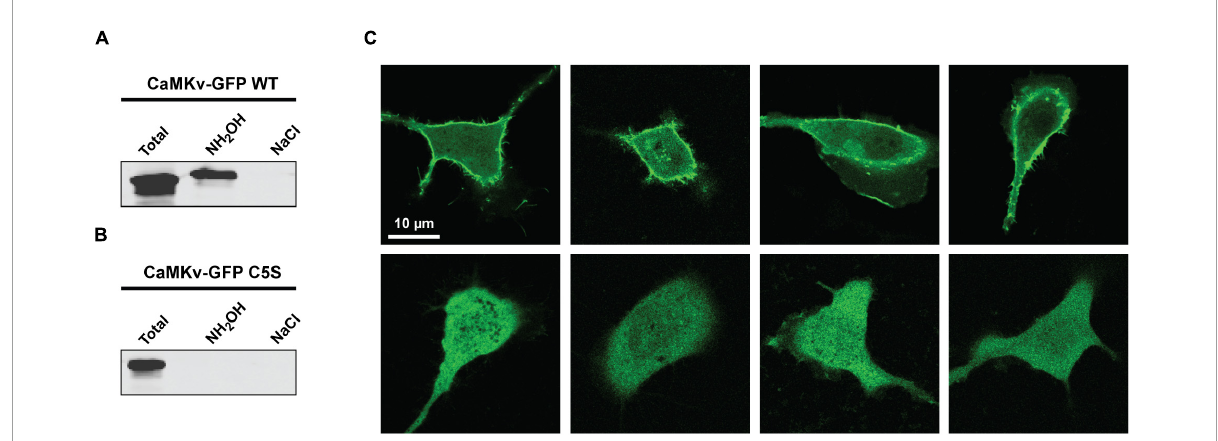
FIGURE3 Effect of suppressing palmitoylation on the subcellular distribution of calmodulin kinase-like vesicle-associated (CaMKv). (A,B) Acyl-RAC analysis showing palmitoylation of wild-type CaMKv-EGFP (A) but not of the C5S mutant of CaMKv-EGFP in HEK-293 cells (B) . Approximately 4% of CaMKv-EGFP was palmitoylated in three separate experiments. (C) Localization of wild-type CaMKv-EGFP (top four panels) and (C5S)-CaMKv-EGFP (bottom four panels) in MCF-10A cells.